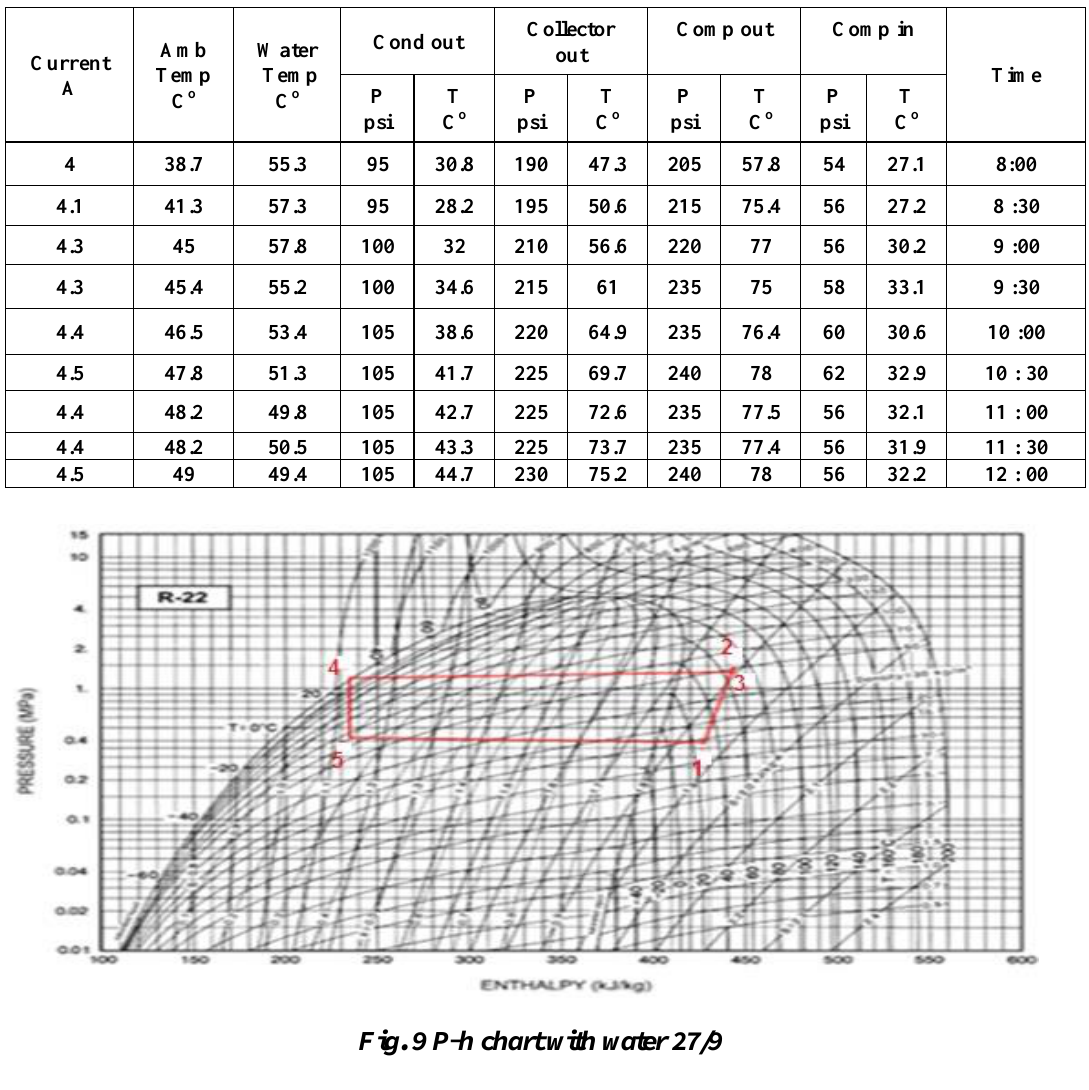
Table 1: Hybrid solar collector with water 27/9.